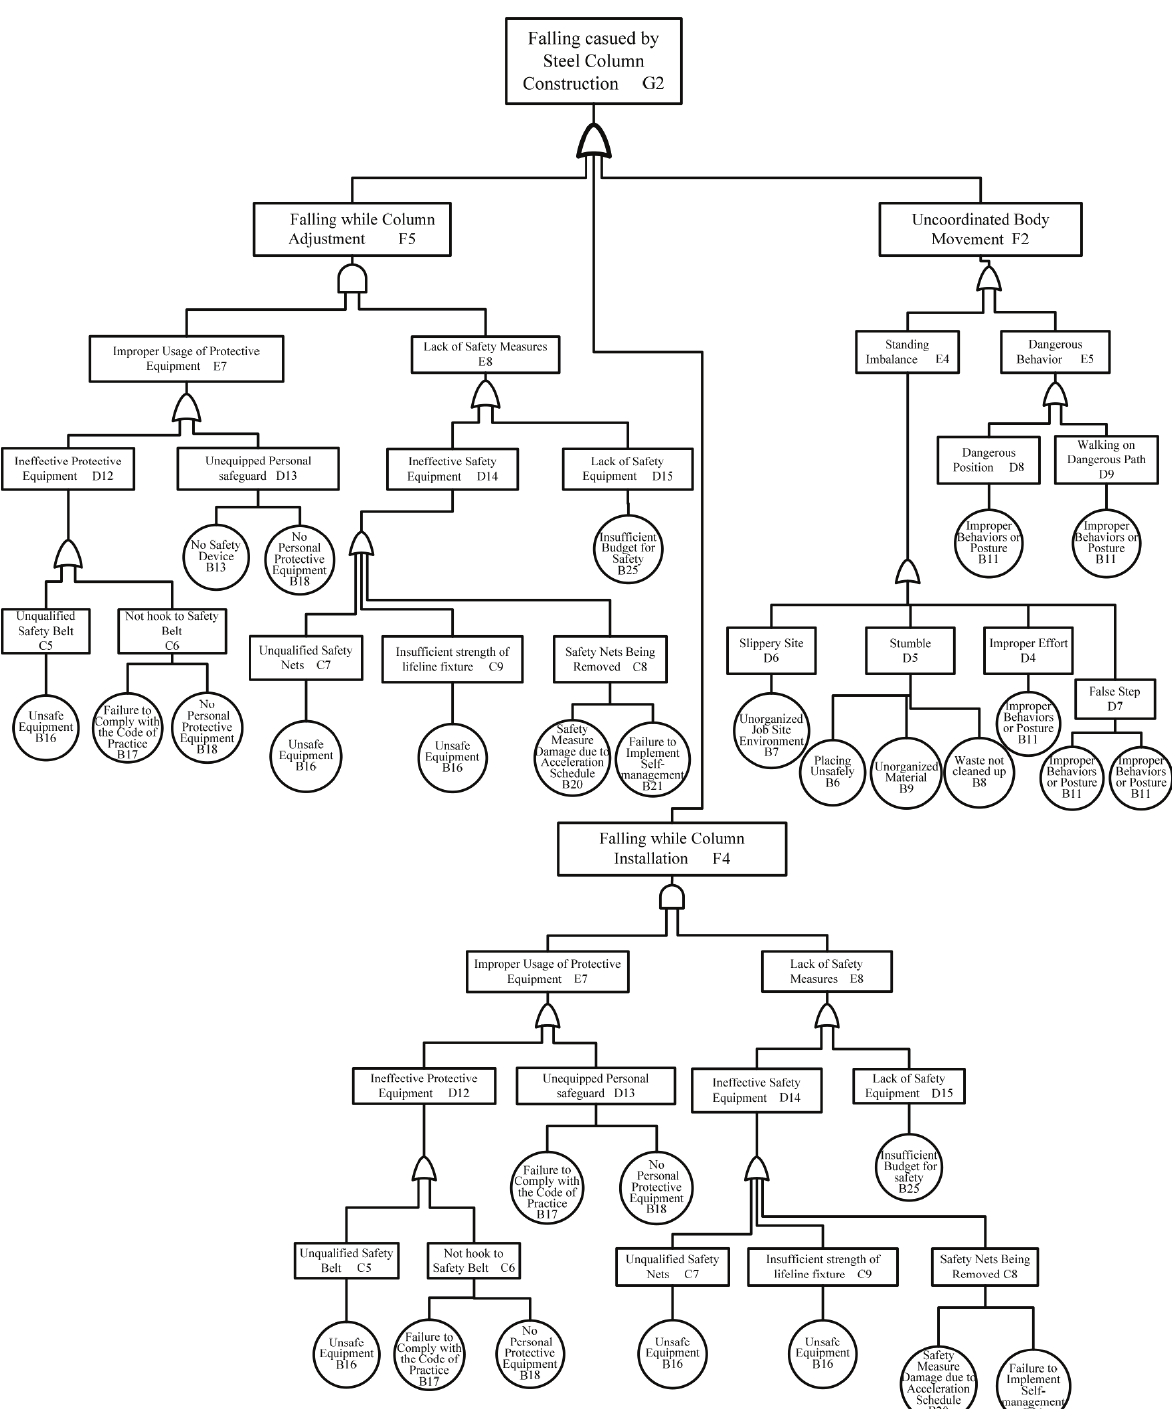
Fig. 3. FT of falling accidents at column erection of SC